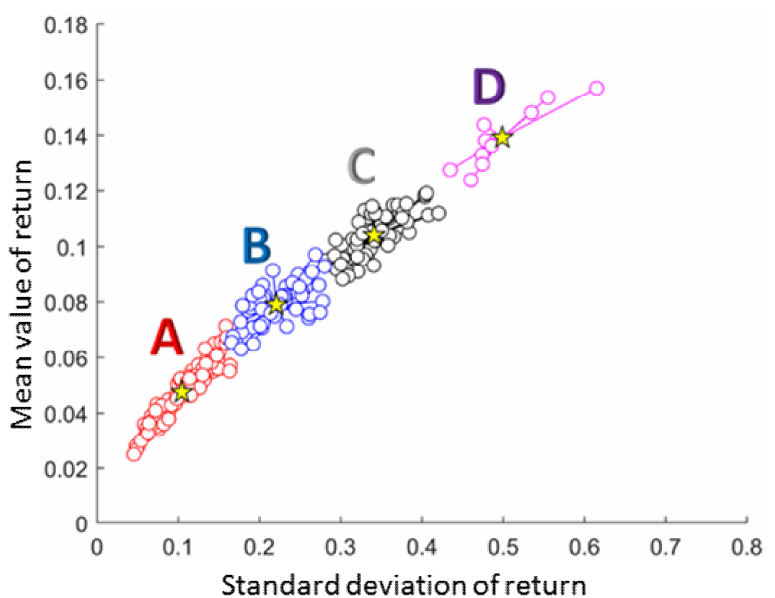
Figure 5. Classification of life extension projects in four groups (A–D) with the centroids of the classified groups (Yellow star)